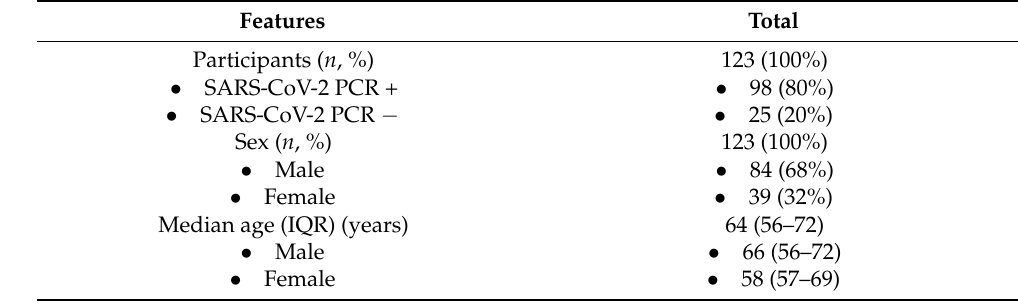
Table 1. Baseline characteristics of participants in the study. Values are numbers (percentages) or median (interquartile